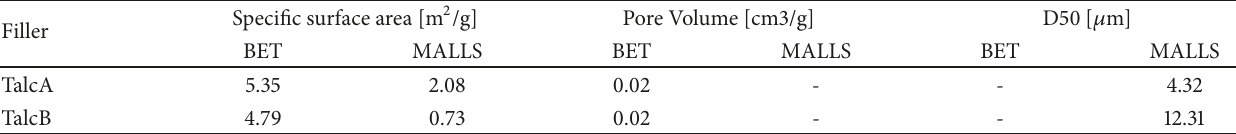
Table 1: BET and MALLS results of fillers’